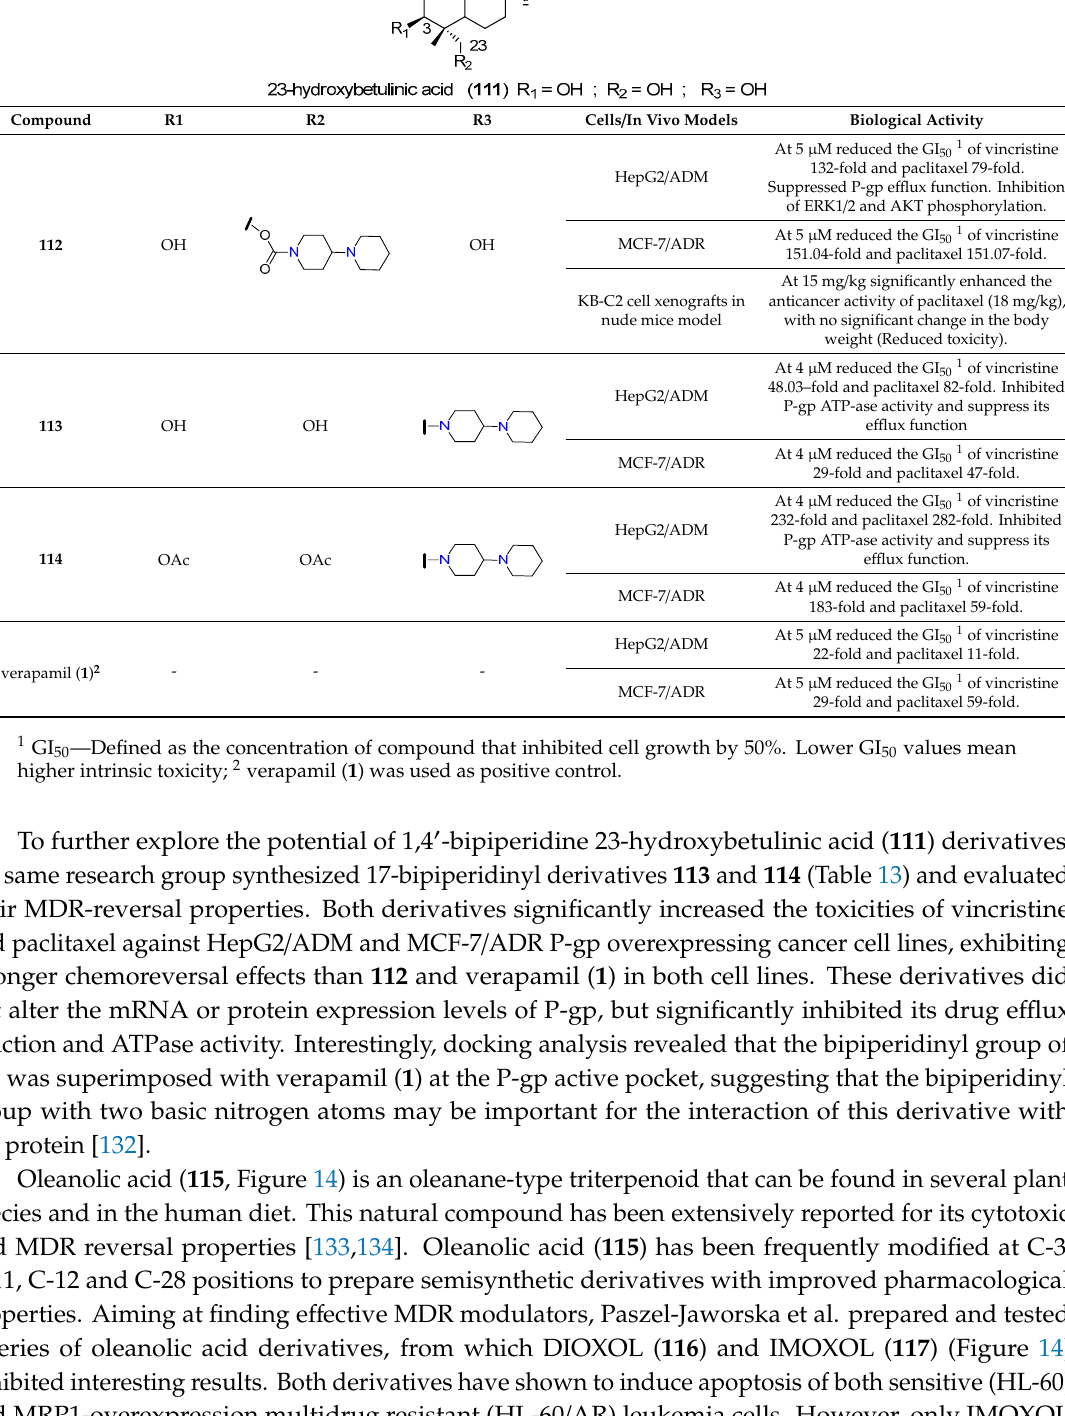
Table 13. P-gp-resistance reversal properties of triterpene derivatives 112 – 114 [131,132].